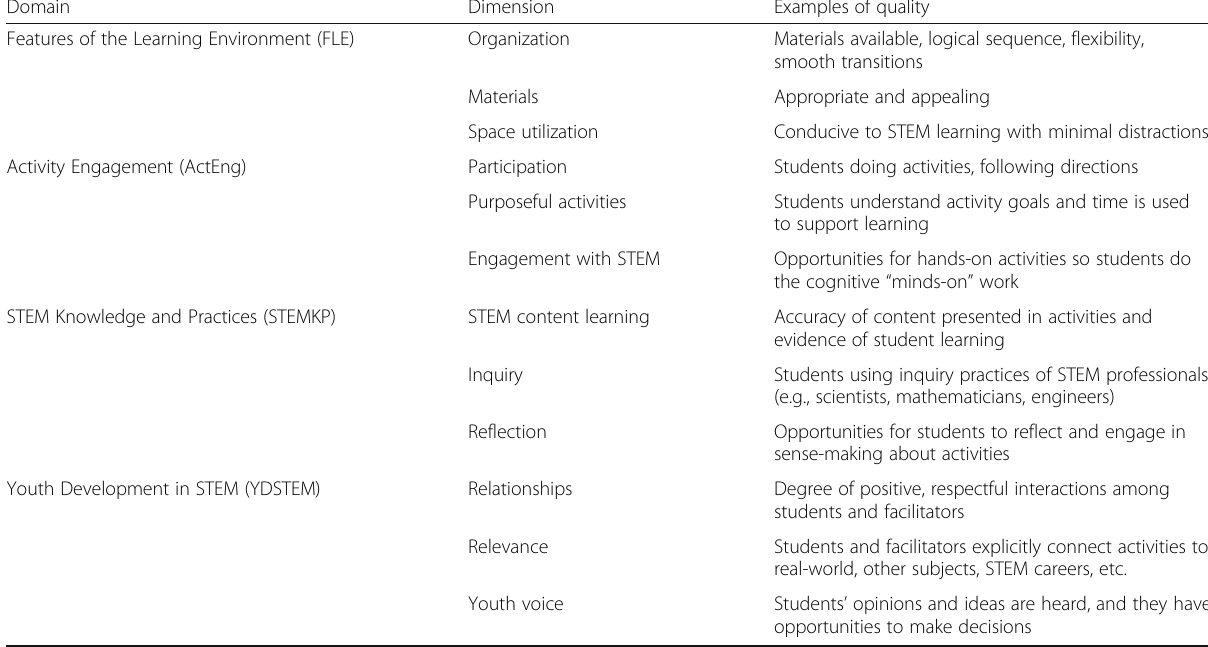
Table 3 Domains, dimensions, and definitions of quality STEM programming for the Dimensions of Success (DoS) observation tool